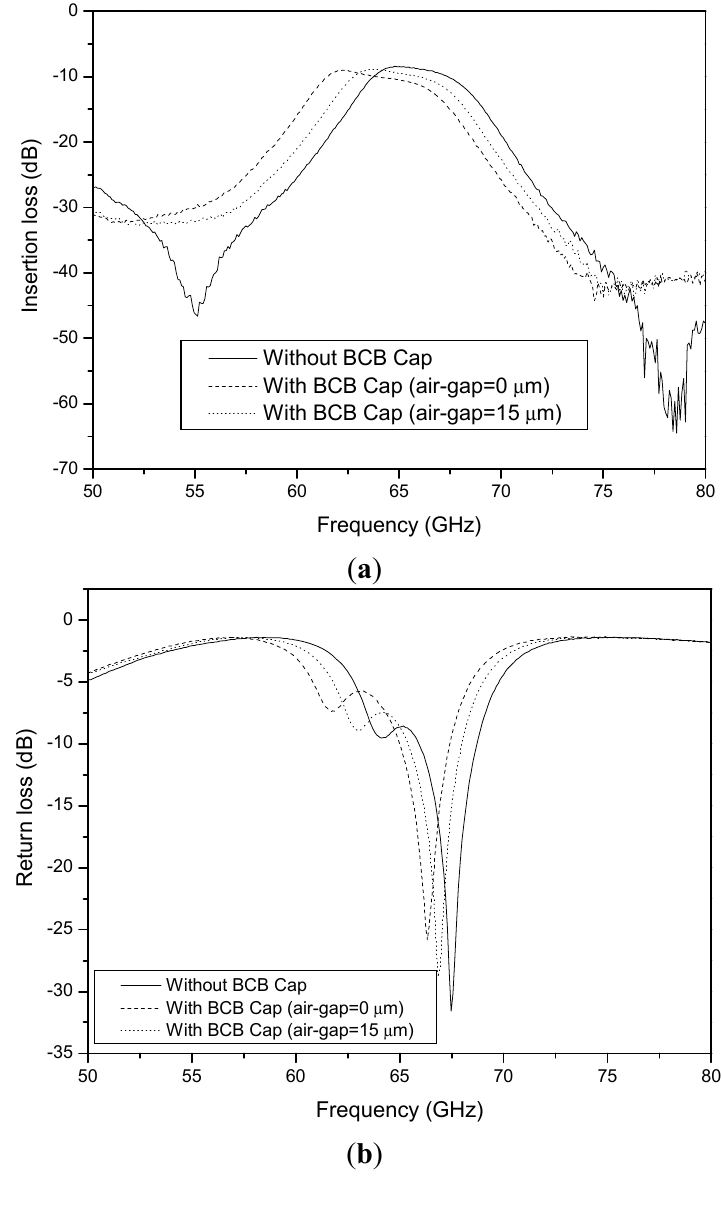
Figure 8. Measured tuning characteristic of the BCB capped tunable filter5. ( a ) Insertion loss. ( b ) Return